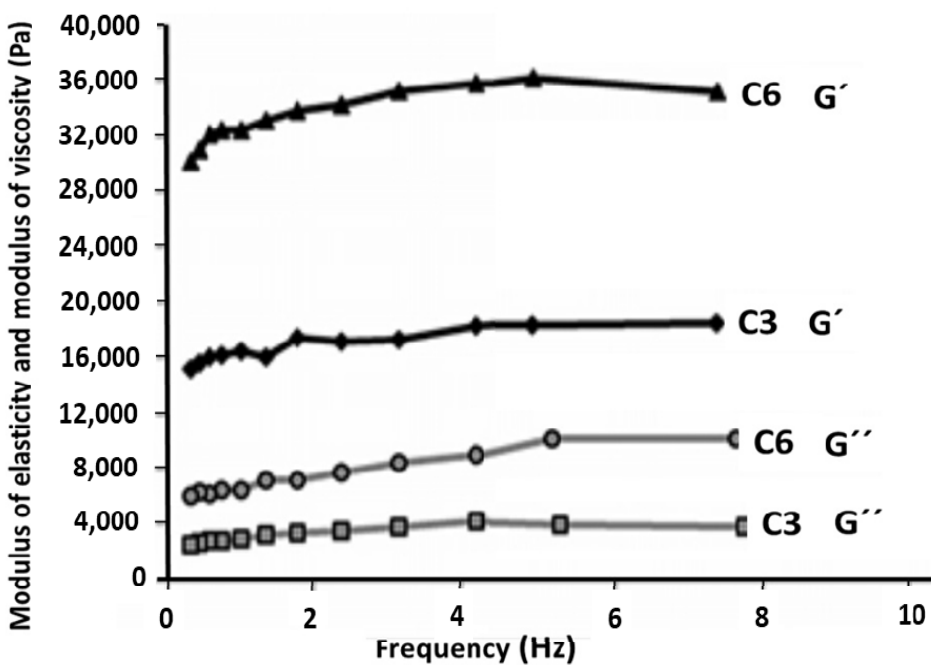
Figure 5. Changes in the elastic and loss modulus of C3 and C6 hydrogels relative to frequency.